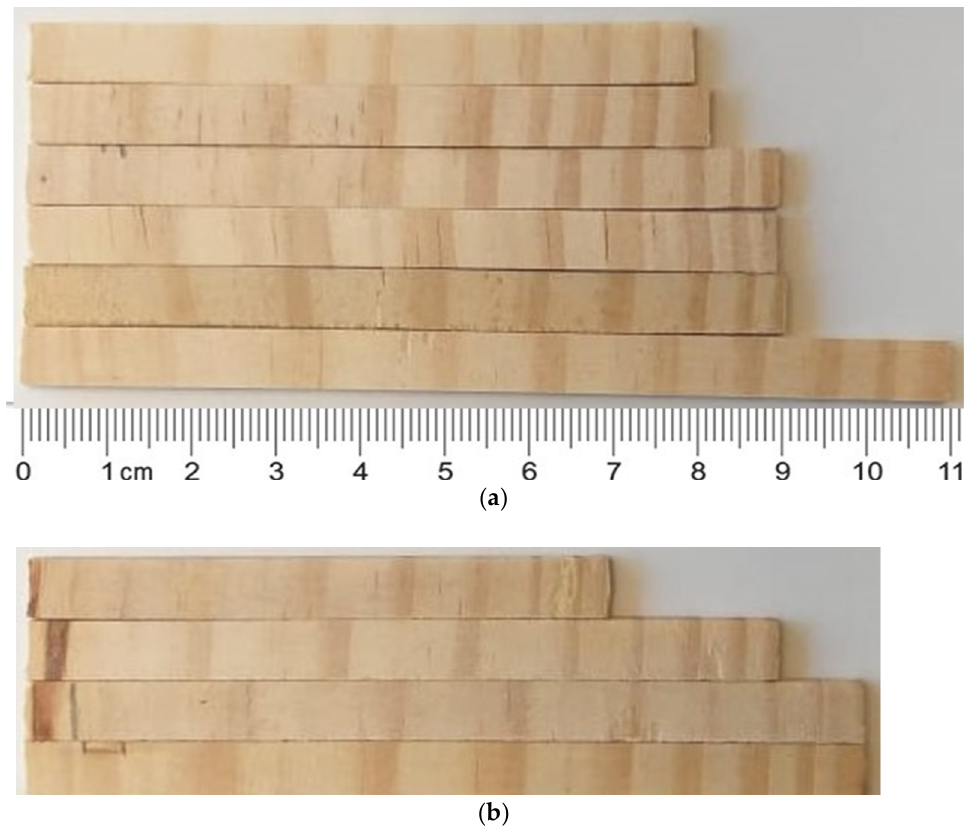
Figure 5. Radial strips for ( a ) Cluster 0 and ( b ) Cluster 3 trees.